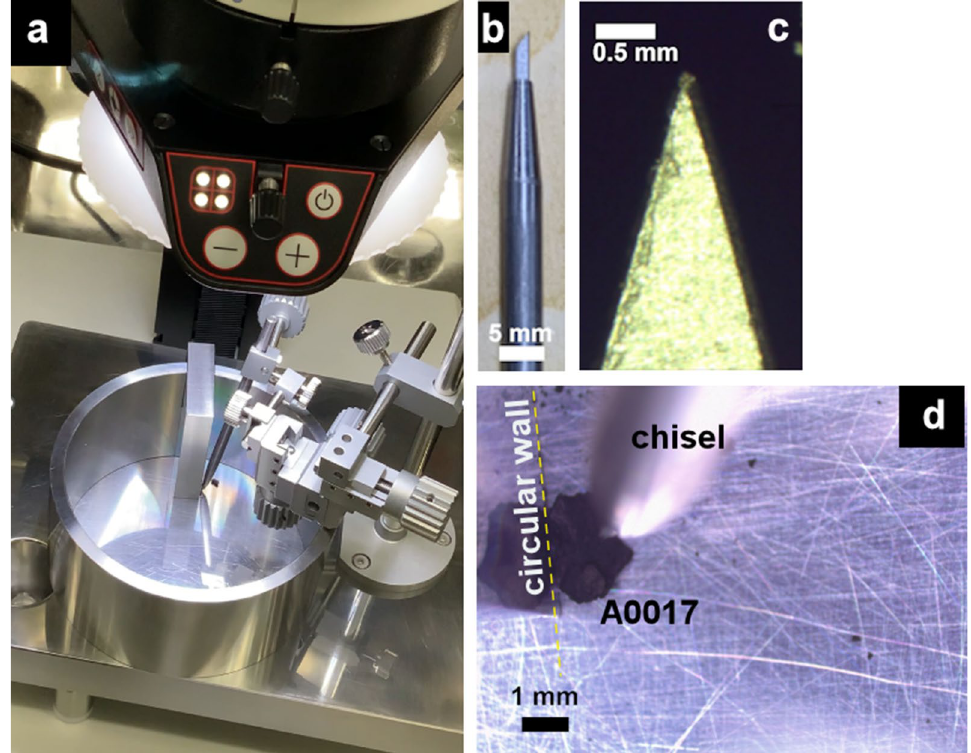
Fig. 3 Chisel setup for the sample division. a Chisel setup under microscope in the glovebox. A circular wall is used to fix the sample and prevent from scattering of divided samples. b Photo of a tantalum chisel. c Photo of the cutting edge of a tantalum chisel after polished by hand using a diamond grindstone. d Microscopic image of sample division. This image was taken just before the division of A0017. The grain was fixed between the circular wall and the